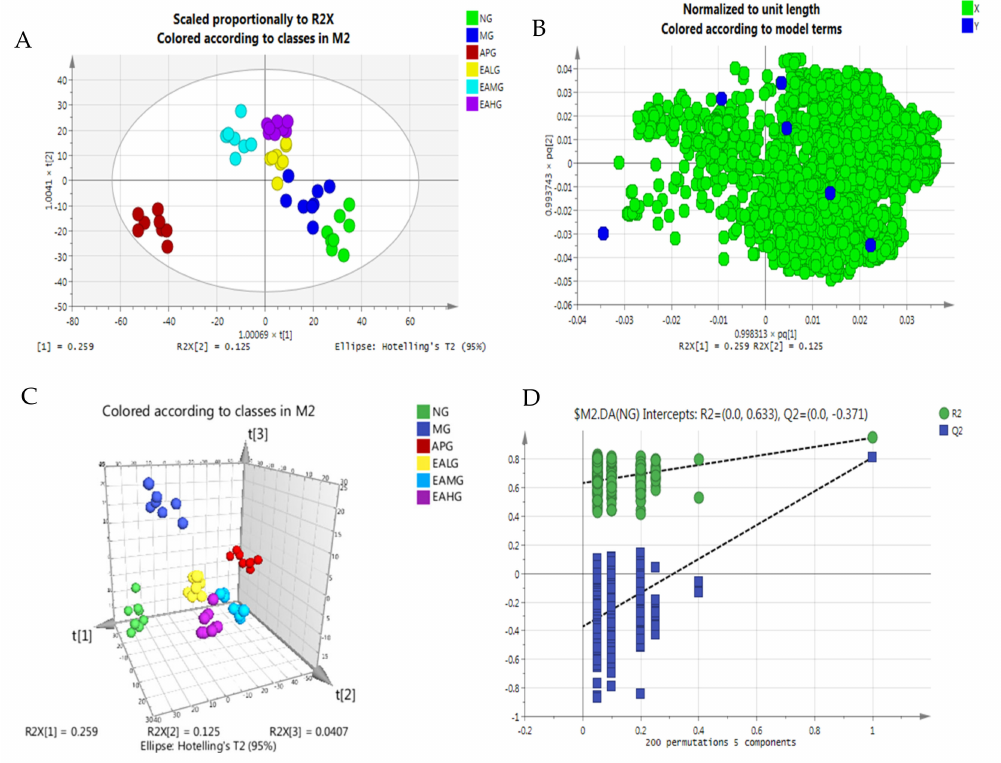
Figure 6. OPLS-DA of serum metabolites. ( A ): scores scatter plot. ( B ): loading of six groups. ( C ): 3D plot. ( D ): random displacement test ( n = 200) and the explanatory rate of the